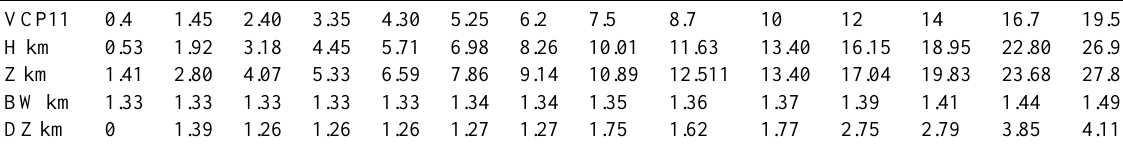
Table 2. For an horizontal distance of 76km from the NexRad radar, in the vertical direction above the NAIC site and as a function of the VCP11 elevation: H: Height of the central beam above NAIC, Z (MSL): altitude of the NexRad central beam above the NAIC site, taking into account the NexRad altitude, BW (km) the vertical size of the beamwidth, DZ (km) the distance between two consecutive central beams.